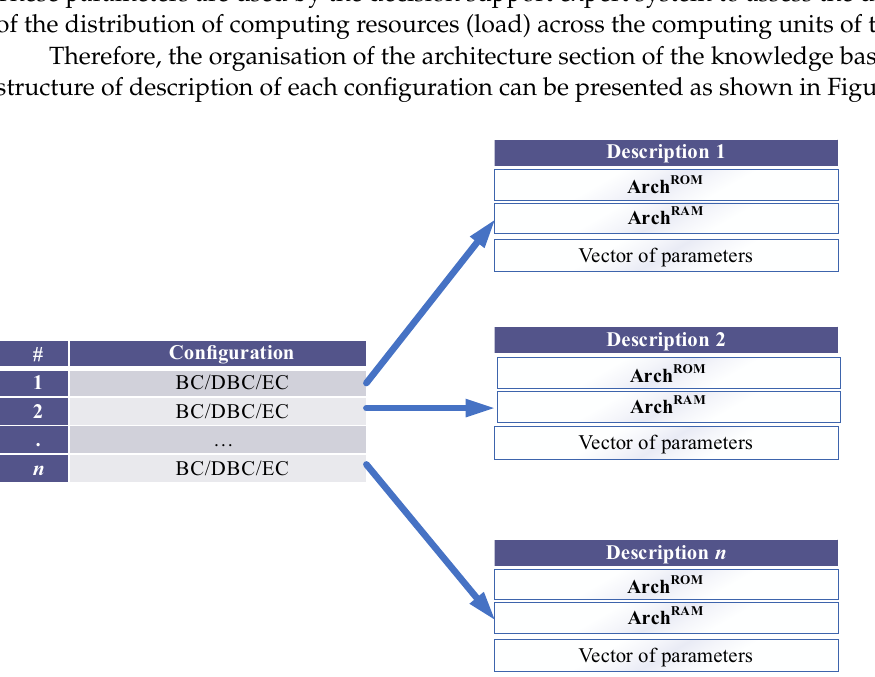
Figure 10. Structure and composition of the architecture section of the knowledge